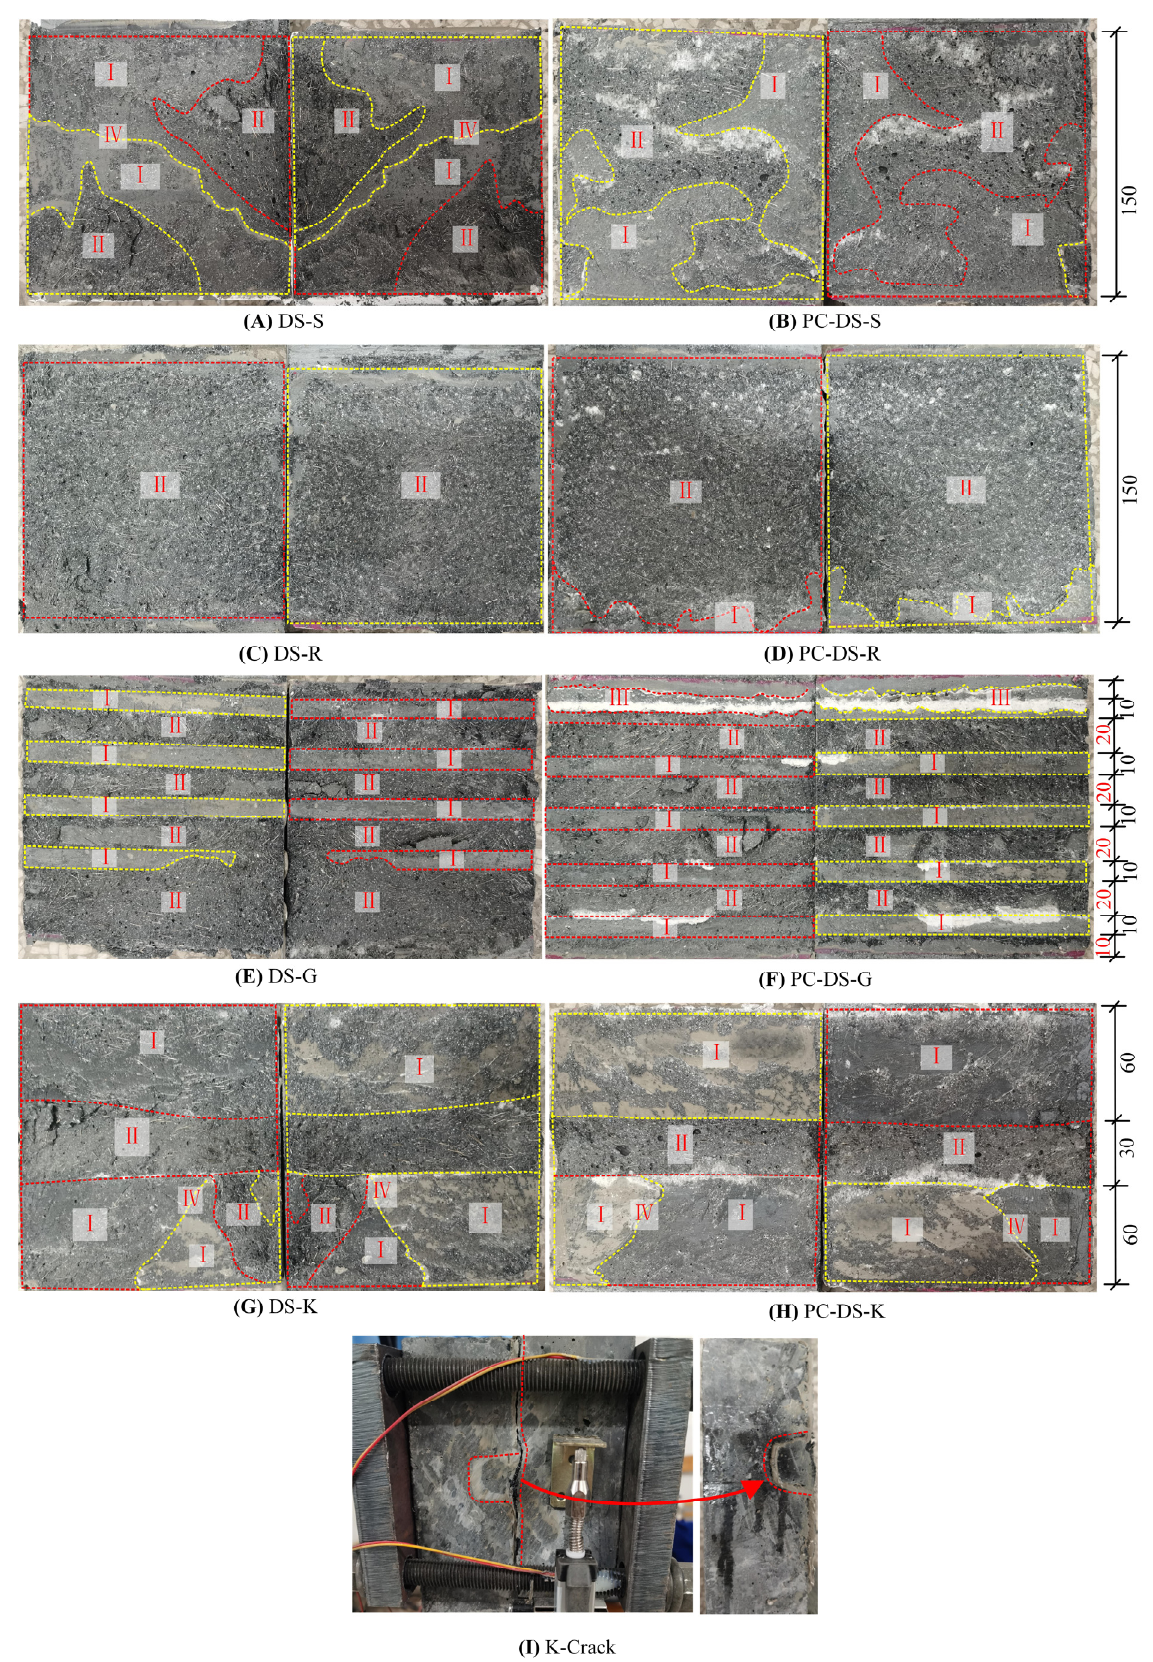
Figure 5. Interface damage state. Unit: mm.